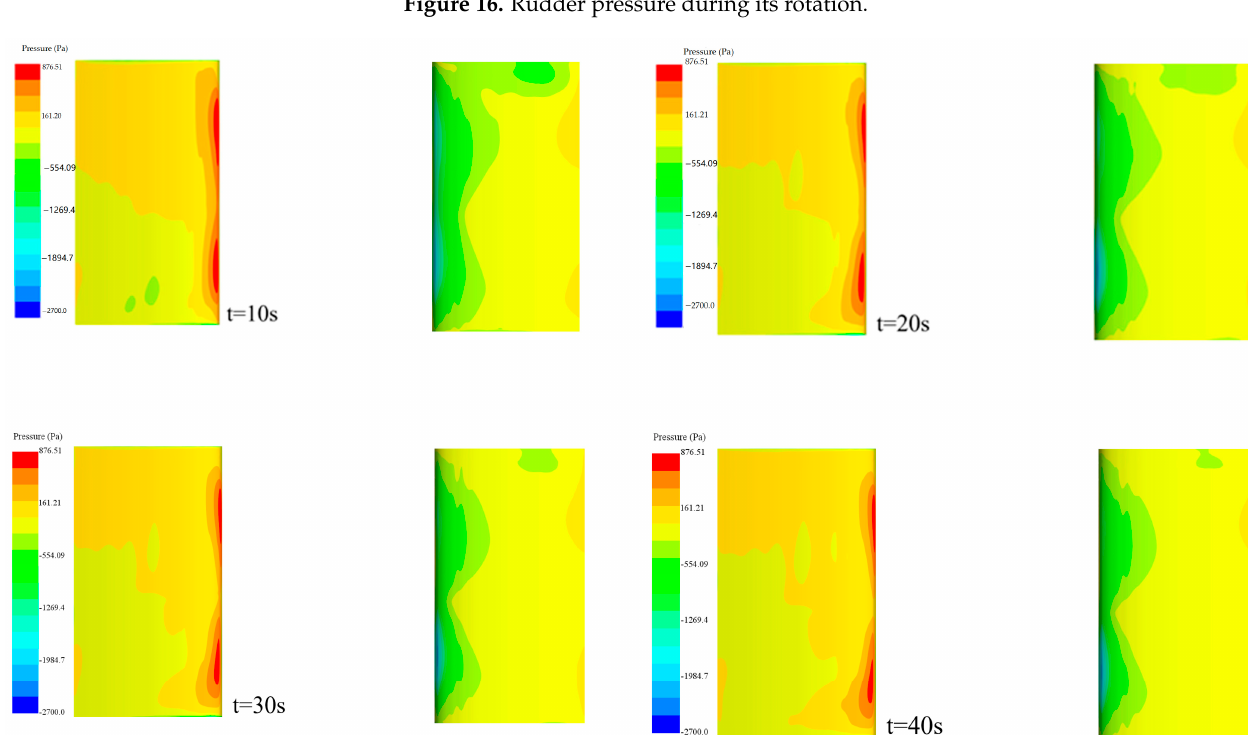
Figure 17. Rudder pressure during transition